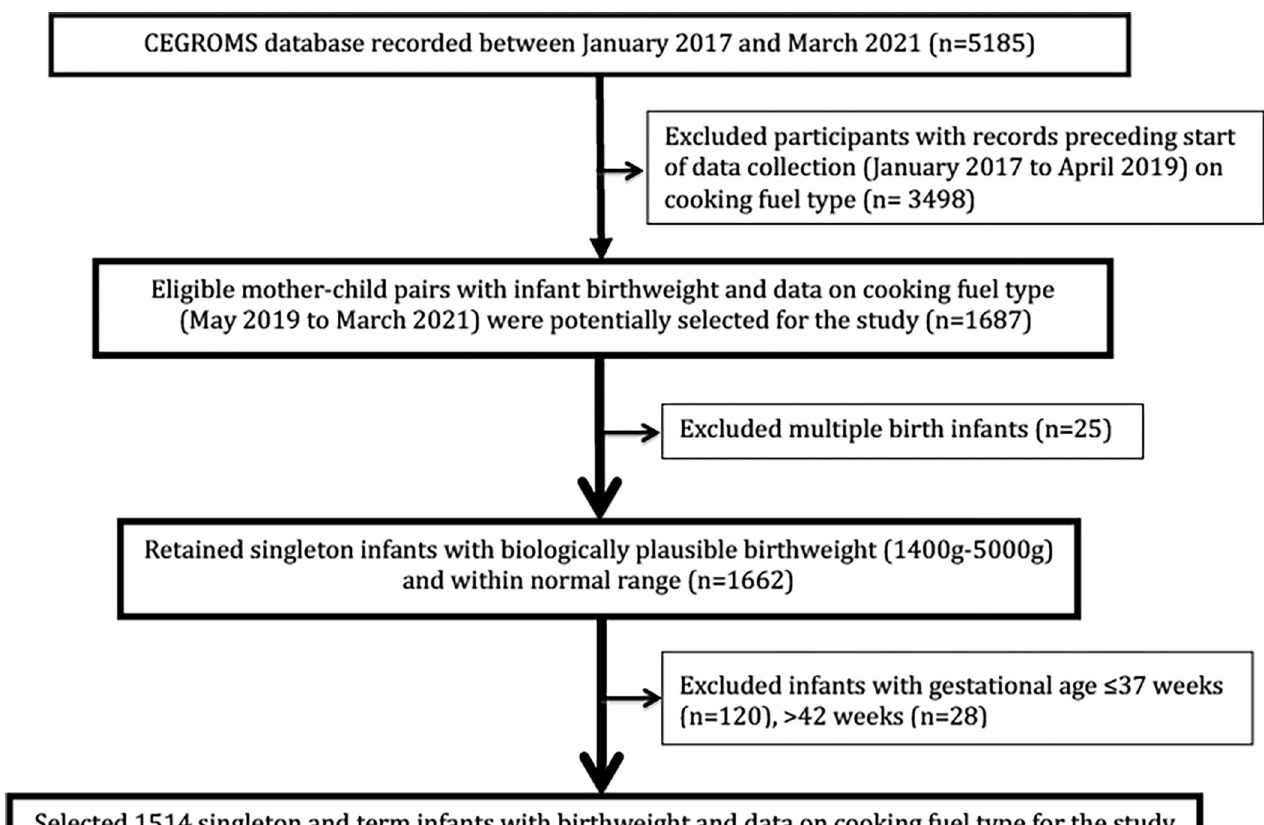
Fig 1. Participant selection flowchart from the